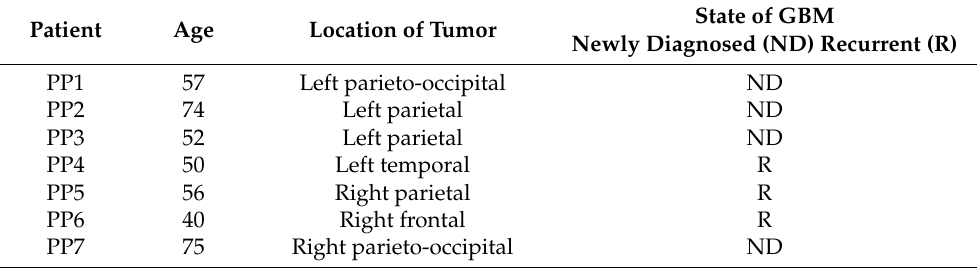
Table 8. Patient data and GBM tumor location and state specifications under